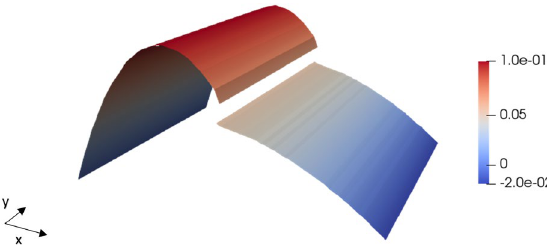
Fig. 16 Elevation of the numerical